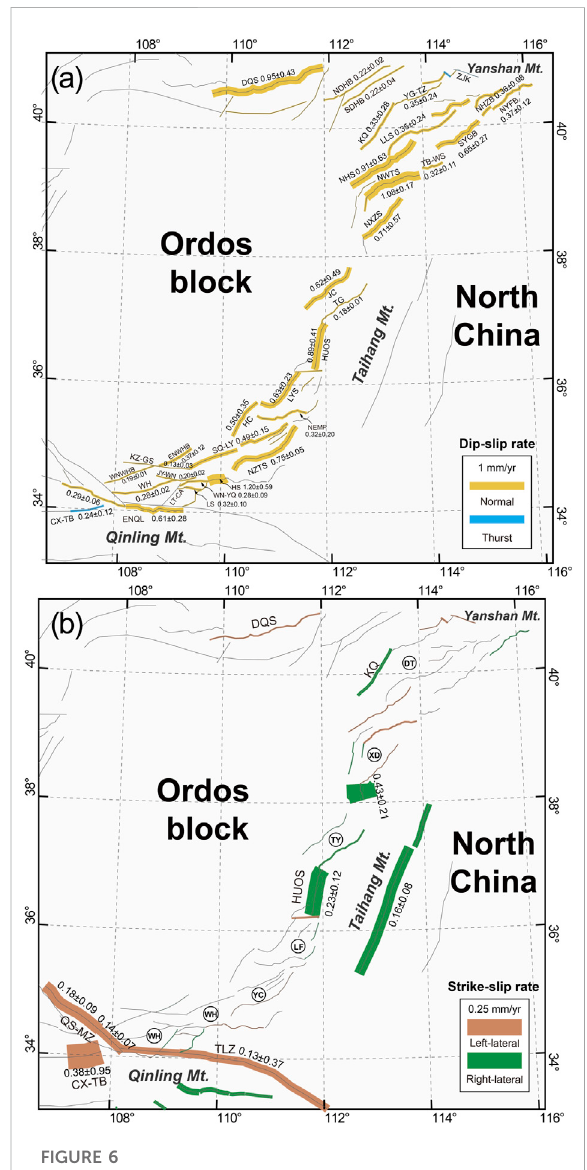
FIGURE 6 Predicteddip-slip (A) andstrike-slip (B) rates.Abbreviationsof faults are given in Figure